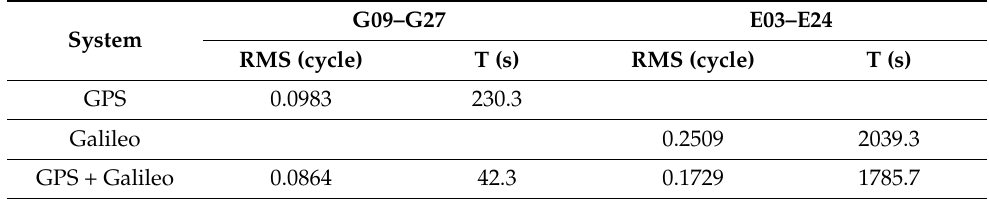
Figure 12. Ambiguity residual of L1 and E1 signal by IF TCAR method in the independent system (upper row) and by CIF TCAR method (lower row) and corresponding satellite elevation angles